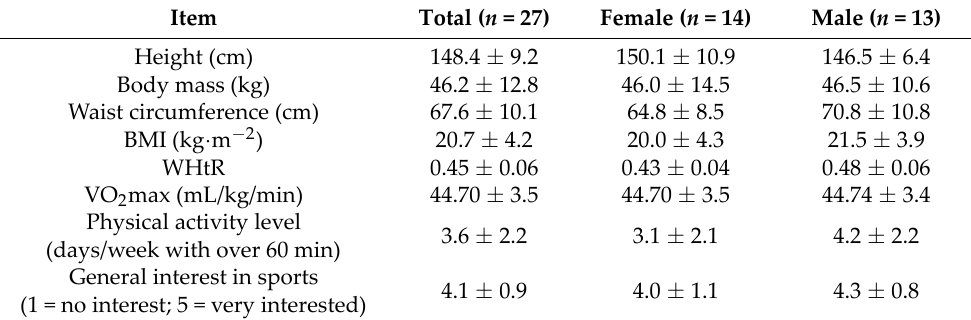
Table 1. Subject’s